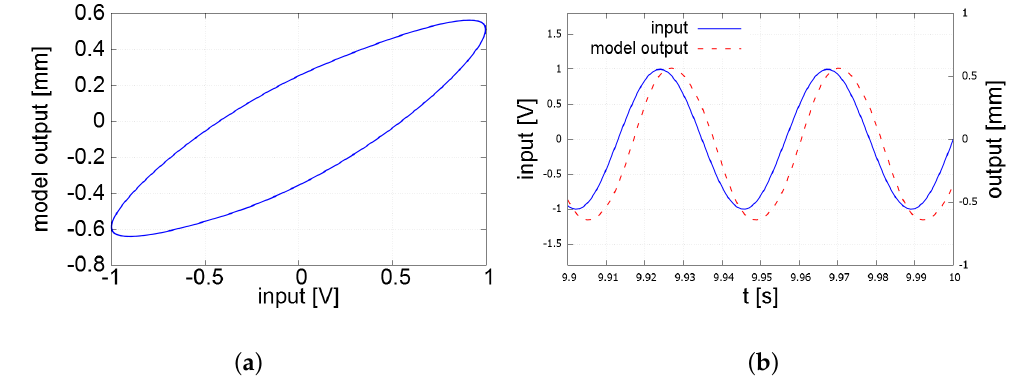
Figure 4. An example of the response of the extended Bouc–Wen model (3) with fictitious parameter values. ( a ) Input/output plane; ( b ) Time